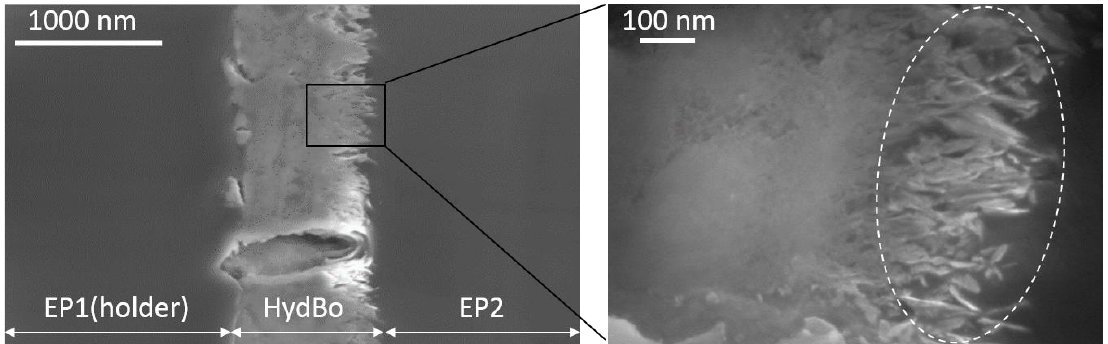
Figure 2. 3 kV SEM micrograph of the cross-sectional surface of EP1/HydBo/EP2 layered